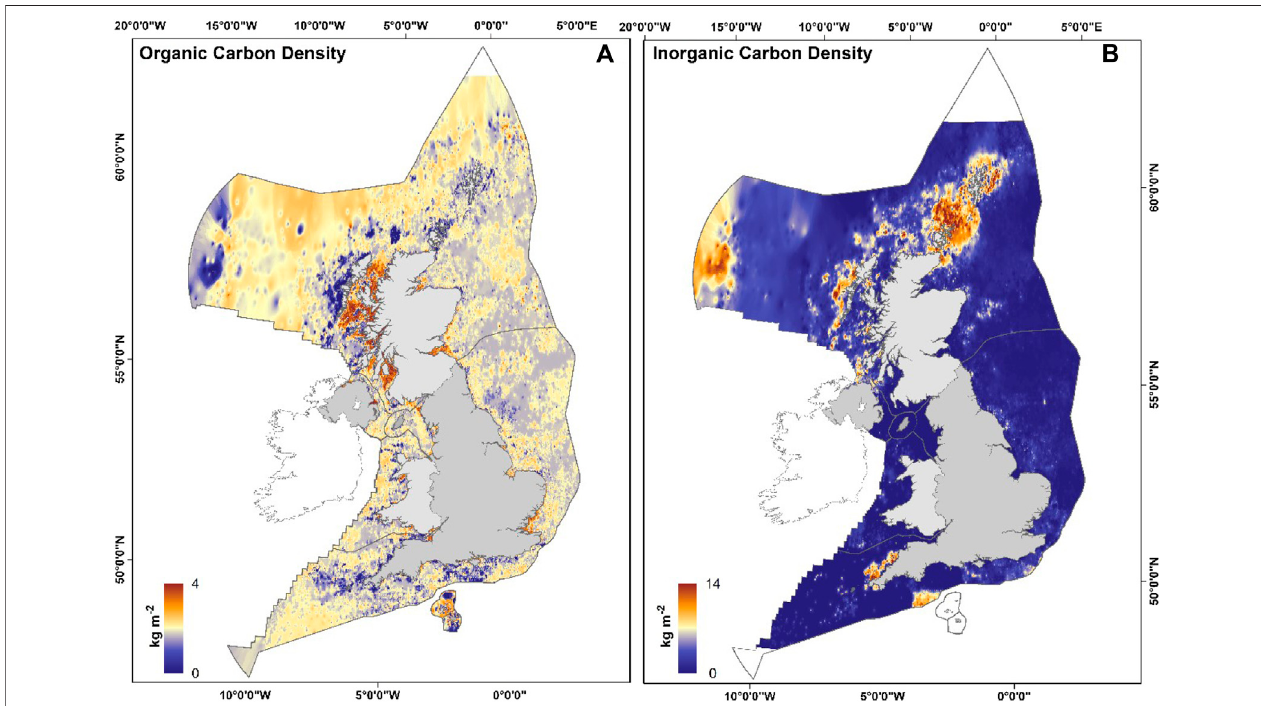
FIGURE 9 | Spatial modeling of the UK EEZ sediments (A) OC density [kg m − 2 ] (B) IC density [kg m − 2 ]. These data layers alongside the porosity, dry bulk density, OC content and IC content data layers are available at https://doi.org/10.7489/12354-1.